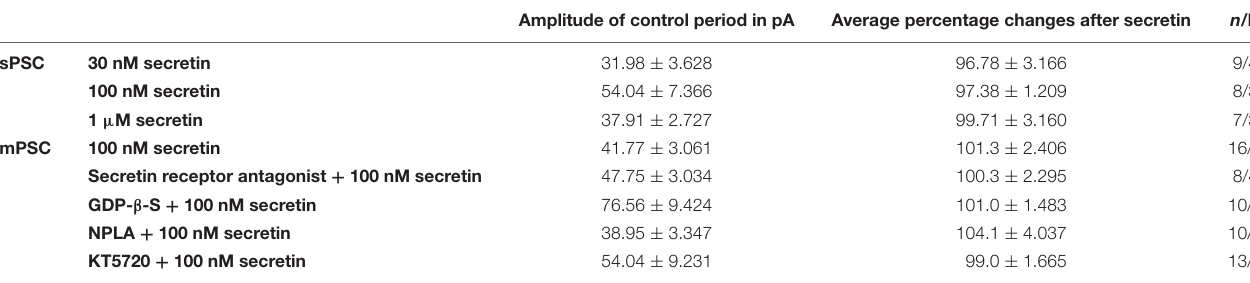
TABLE 2 | Changes in the amplitude of PSCs upon secretin treatment.